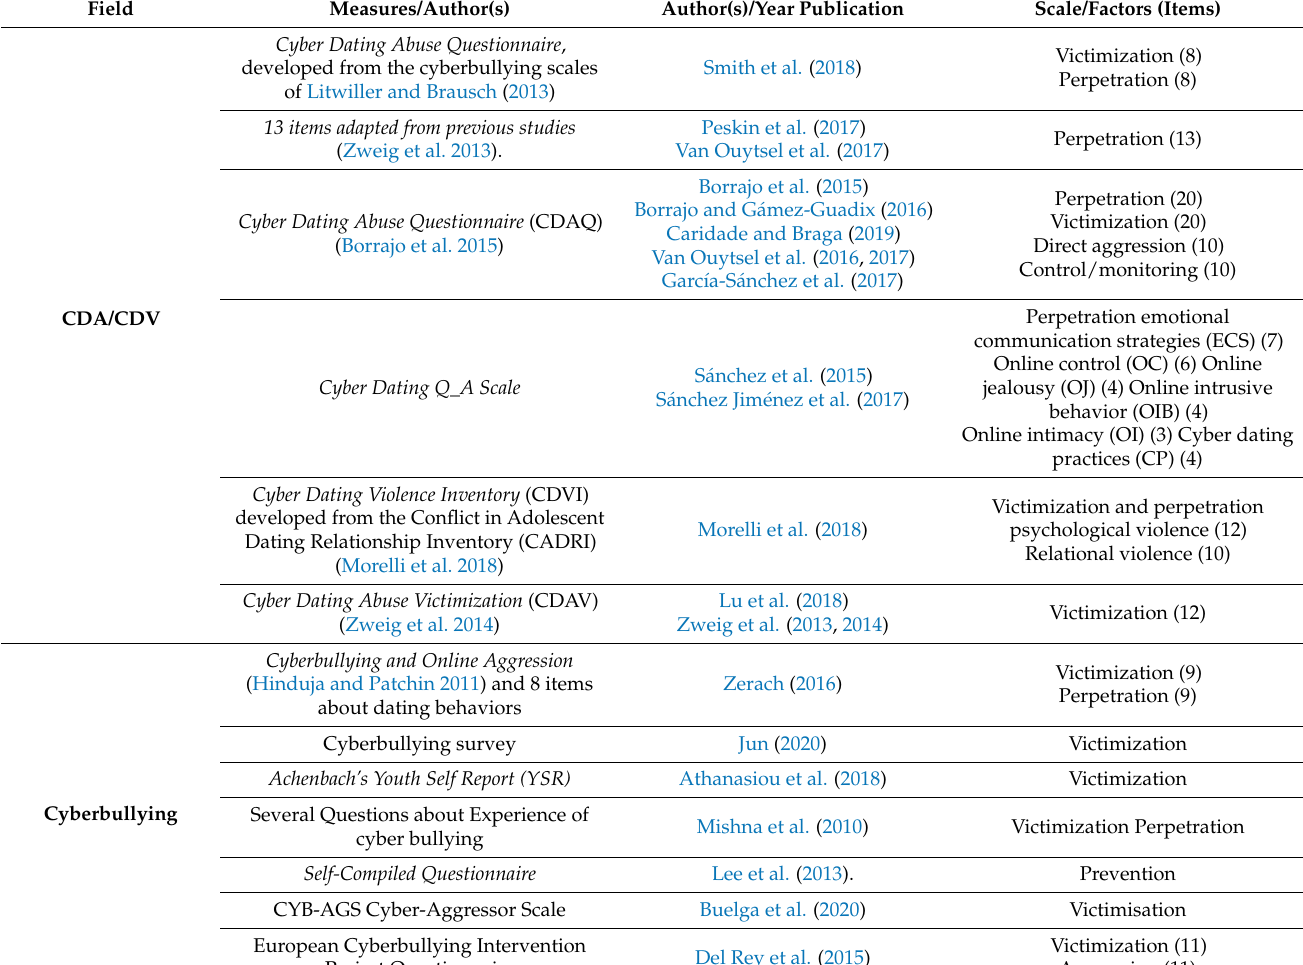
Table 2. Tools used to assess